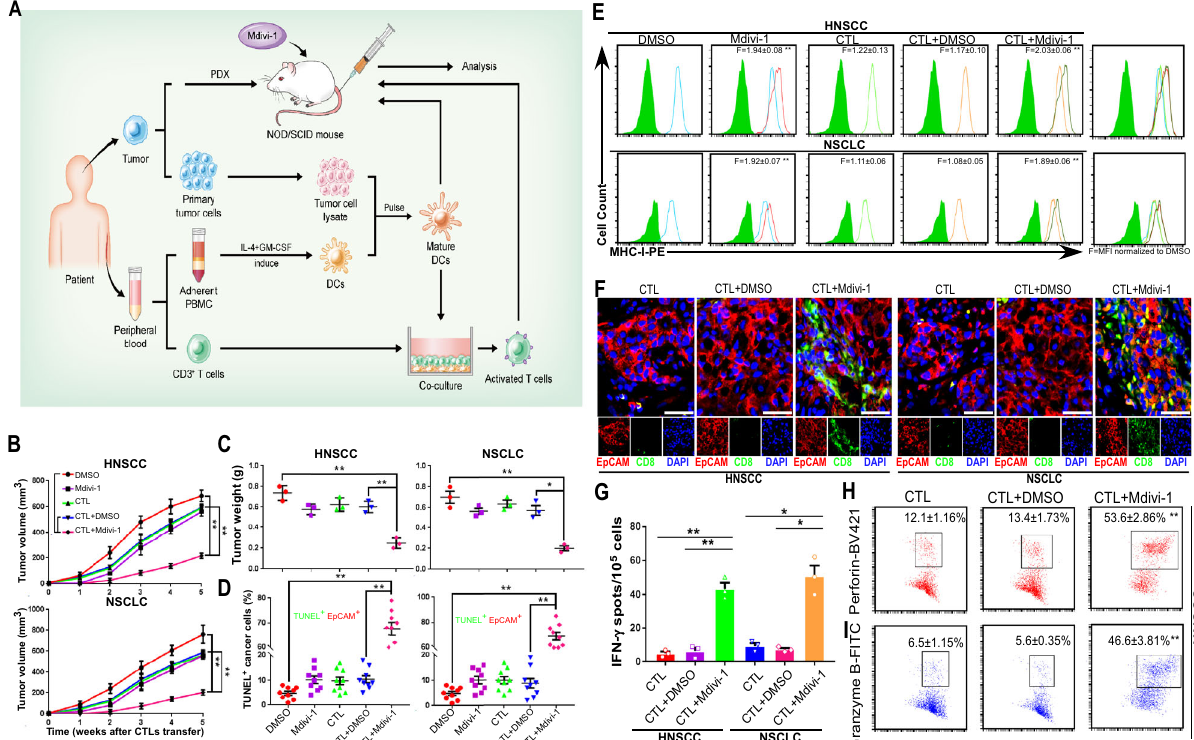
Fig. 3 Mdivi-1 improves the adoptive T cell therapy (ACT) in PDX tumor models by upregulating MHC-I. A Scheme of ACT therapy through tumor- speci fi c CTLs transferred into NOD/SCID mice transplanted with autologous HNSCC or NSCLC PDXs. B Tumor volume measurements were monitored weekly after ACT for fi ve consecutive weeks (mean ± s.e.m; n = 3 per PDX group; p < 0.0001 for both HNSCC and NSCLC; ** p < 0.001 by two-way ANOVA followed by Dunnett ’ s tests for multiple comparisons). C Weights of harvested HNSCC or NSCLC PDXs (mean ± s.e.m; n = 3 per PDX group; p = 0.0003, 0.0006 for HNSCC and 0.0006, 0.0011 for NSCLC; * p < 0.01, ** p < 0.001 by one-way ANOVA followed by Dunnett ’ s tests for multiple comparisons). D Apoptosis of cancer cells as determined by EpCAM and TUNEL immunostaining (mean ± s.e.m; n = 9, 3 sections per PDX; p < 0.0001 for both HNSCC and NSCLC; ** p < 0.001 by one-way ANOVA followed by Dunnett ’ s tests for multiple comparisons). E Flow cytometric analysis of MHC-I membrane expression in isolated HNSCC and NSCLC primary cancer cells. F indicates the fold change of MFI (mean fl uorescence intensity) normalized to DMSO group (mean ± s.e.m; n = 3 per PDX group; p < 0.0001 or = 0.0792, 0.3609, 0.0002 for HNSCC and 0.0002, 0.0792, 0.3855, 0.0008 for NSCLC; ** p < 0.001 compared with ACT accompanied by DMSO treatment or DMSO alone by one-way ANOVA followed by Dunnett ’ s tests for multiple comparisons). F Representative immuno fl uorescence images for EpCAM and CD8 of harvested PDXs (EpCAM: red; CD8: green). DAPI, nuclear staining. Scale bars, 25 μ m. G Number of IFN- γ -producing CTLs as quanti fi ed by ELISpot (mean ± s.e.m; n = 3 per PDX group; p = 0.0002, 0.0004 for HNSCC and 0.0017, 0.0013 for NSCLC; * p < 0.01, ** p < 0.001 by two-tailed t -test). H , I Evaluation of intracellular markers in association with cytotoxic function by fl ow cytometry (mean ± s.e.m; n = 3 per PDX group; p = 0.3405 or p < 0.0001 for perforin and 0.8773 or p < 0.0001 for granzyme B; ** p < 0.001 compared with ACT accompanied by DMSO treatment by two-tailed t